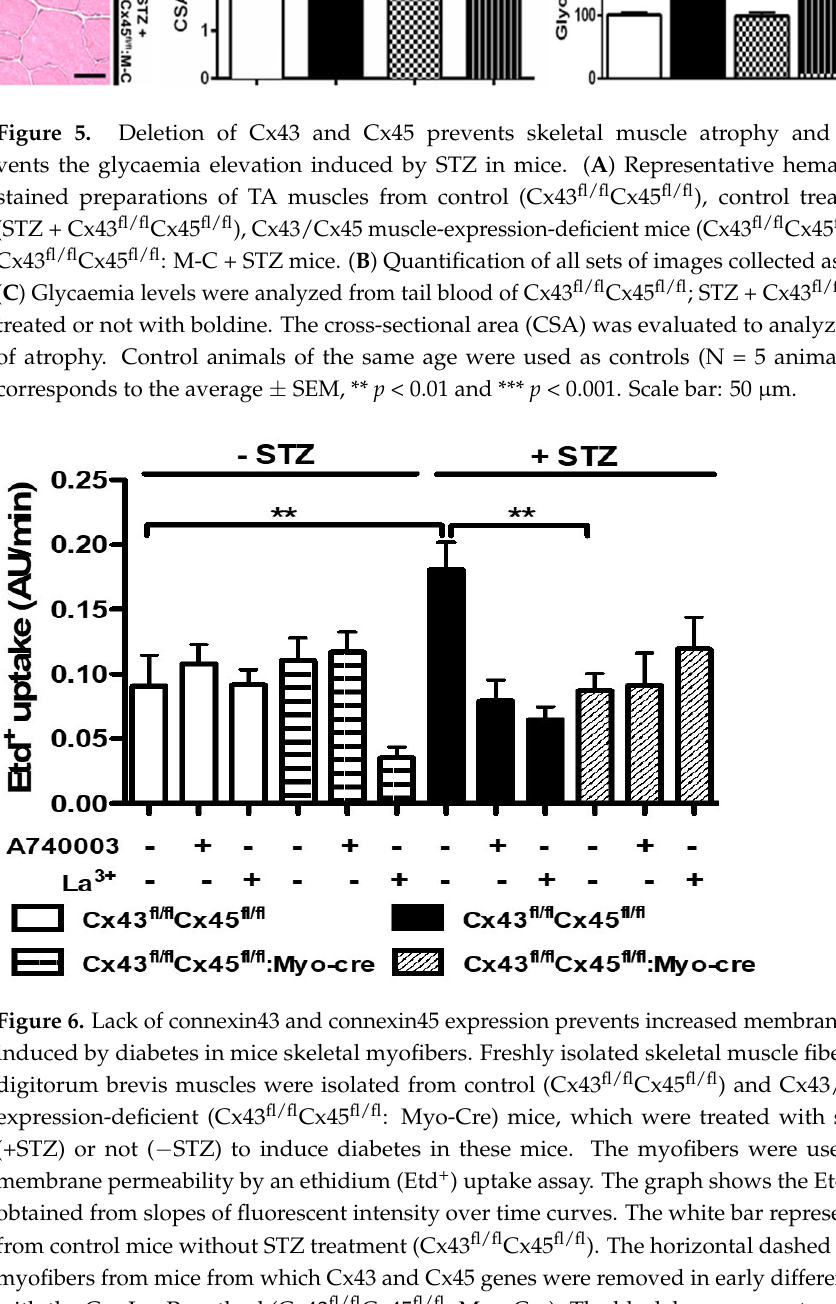
plus 14.5 mM mannitol) presented a dye uptake rate of 0.042 ± 0.04 AU/min, which was very close to that of the control myofibers described above.